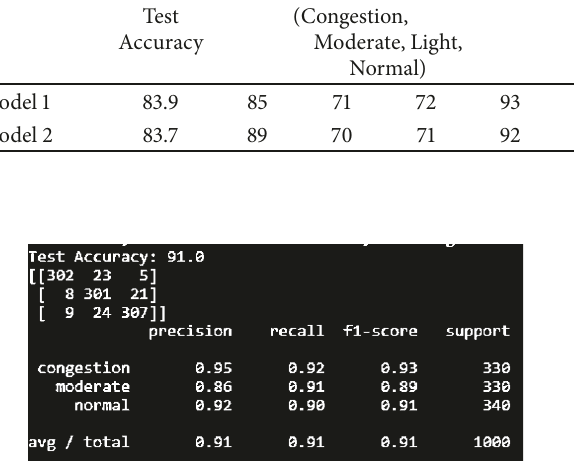
Figure 10: Confusion matrix and the resulting report with re- sample. Weights set to average and hidden size set to